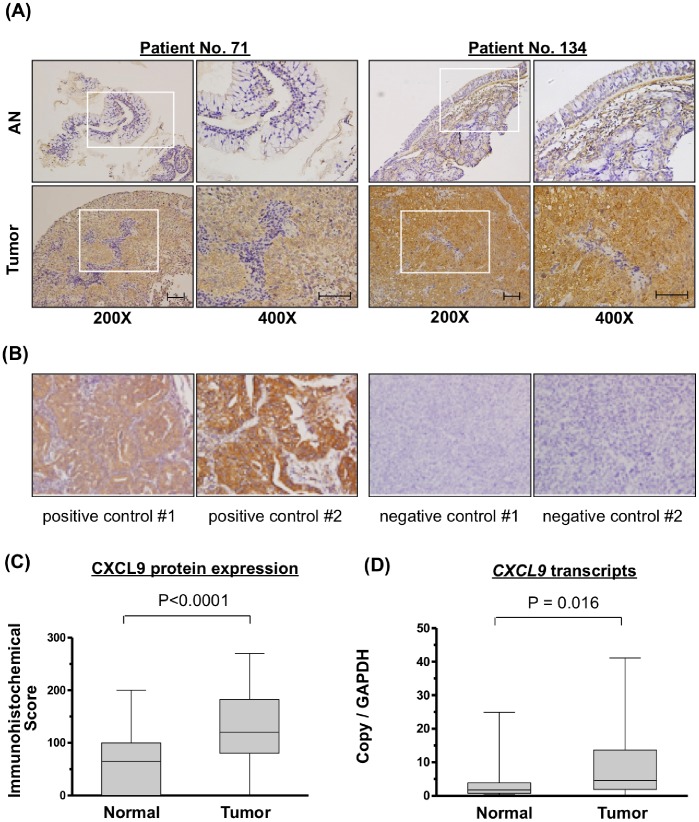
Overexpression of CXCL9 in NPC tissues.(A) Immunohistochemical staining of CXCL9 in paired pericancerous adjacent normal (AN) and tumor tissues from two representative cases (scale bar: 100 µm). Brown signals indicate the CXCL9 expression. Images in the box (left panel, 200x) were enlarged and shown in the right panel (400x). (B) Positive and negative controls for CXCL9 staining. (C) Box and whisker plots showing the immunohistochemical staining scores of CXCL9 in 40 paired AN and tumor tissues. (D) Box and whisker plots showing CXCL9 mRNA transcript levels in the 16 paired pericancerous AN and tumor tissues, as assessed by quantitative real-time RT-PCR. CXCL9 was highly overexpressed in both analyses for NPC tissues. Box, the range of the middle 50% of CXCL9 level; line inside box, median; whiskers, minimal to maximal levels.